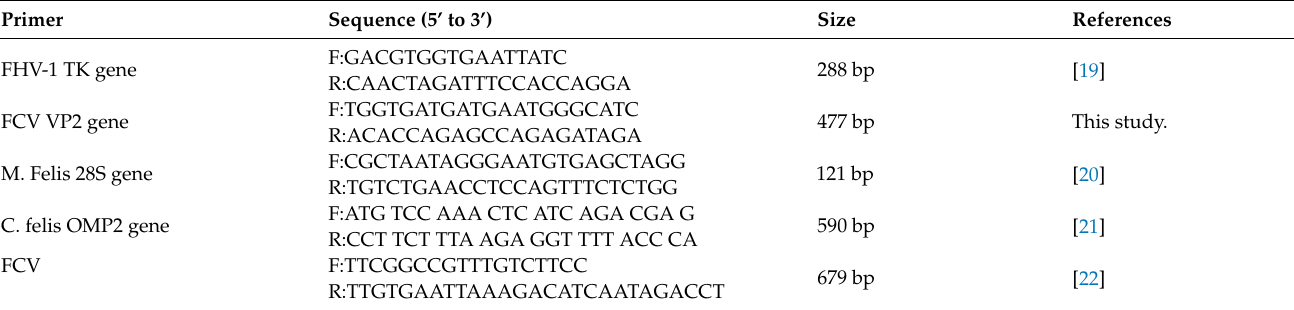
Table 1. The PCR primers involved in this